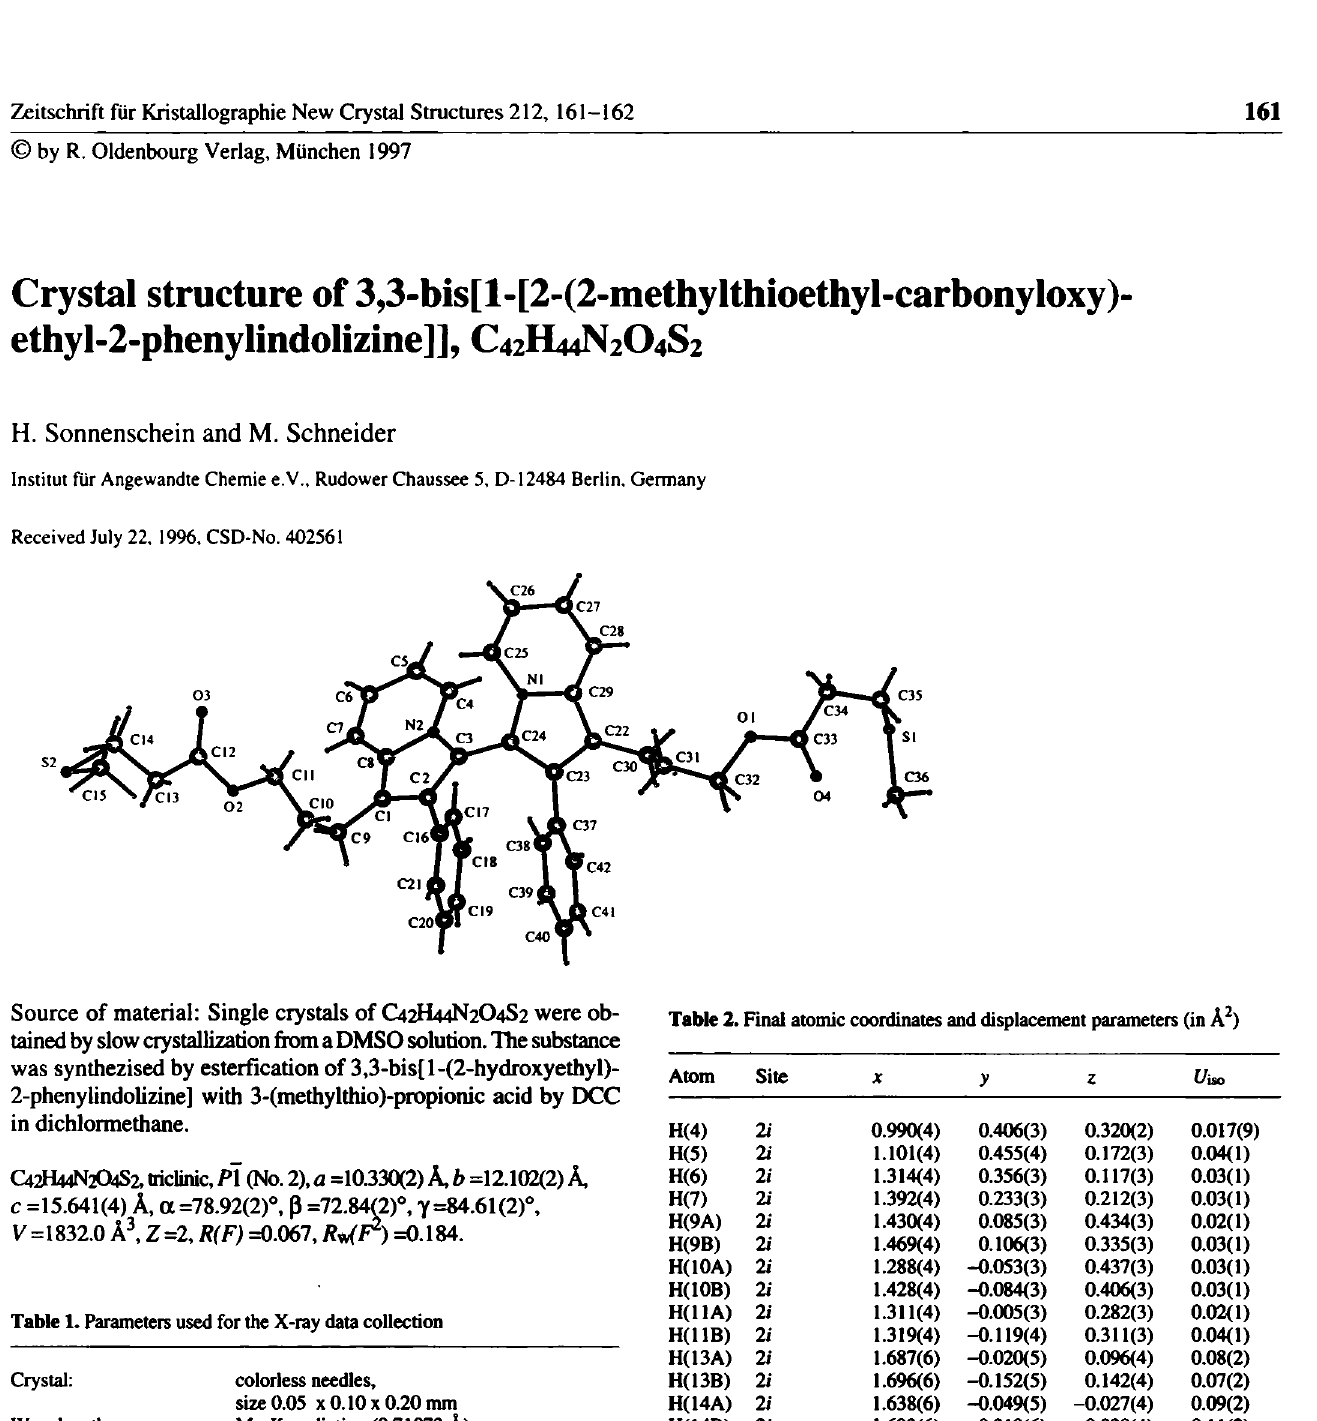
Table 1. Parameters used for the X-ray data collection